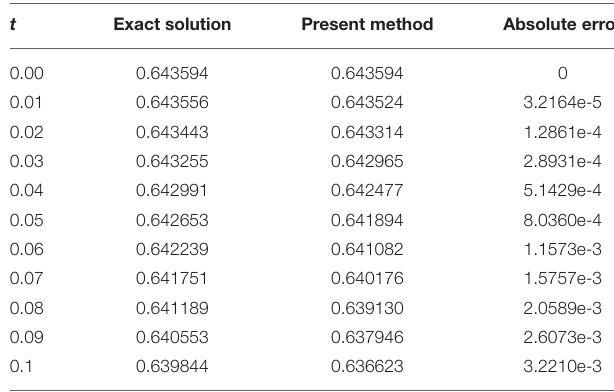
TABLE 1 | Comparison with the exact solution at α equation.